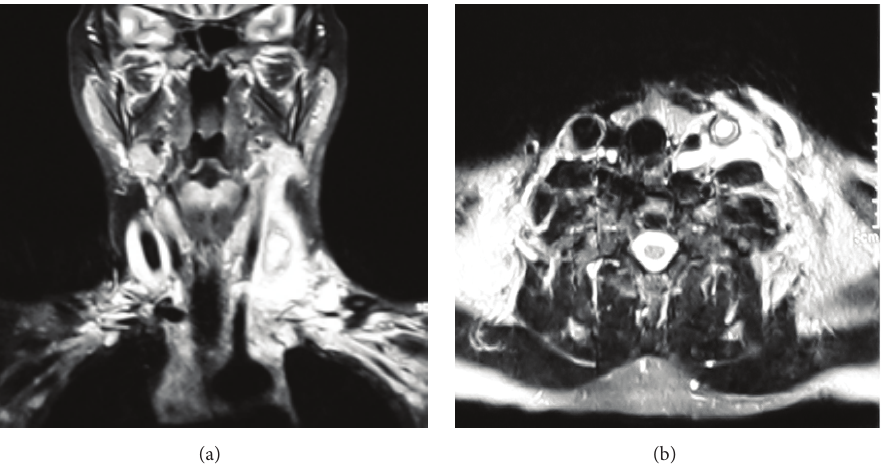
Figure 1: Magnetic resonance imaging of the left internal jugular vein thrombosis: (a) coronal plane, (b) axial